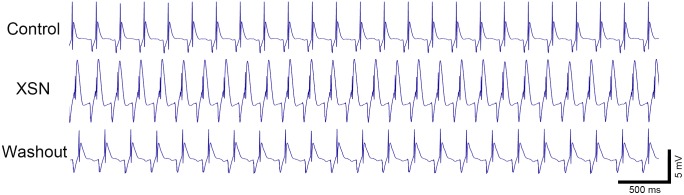
The effect of XSN on the ECG of ex vivo perfused rat heart. XSN at 0.4 g/L decreased the R wave amplitude, but increased T wave amplitude without changing QRS and QT interval. Heart rate (RR interval) did not show significant changes during XSN application and at 10 min washout of the medicine.